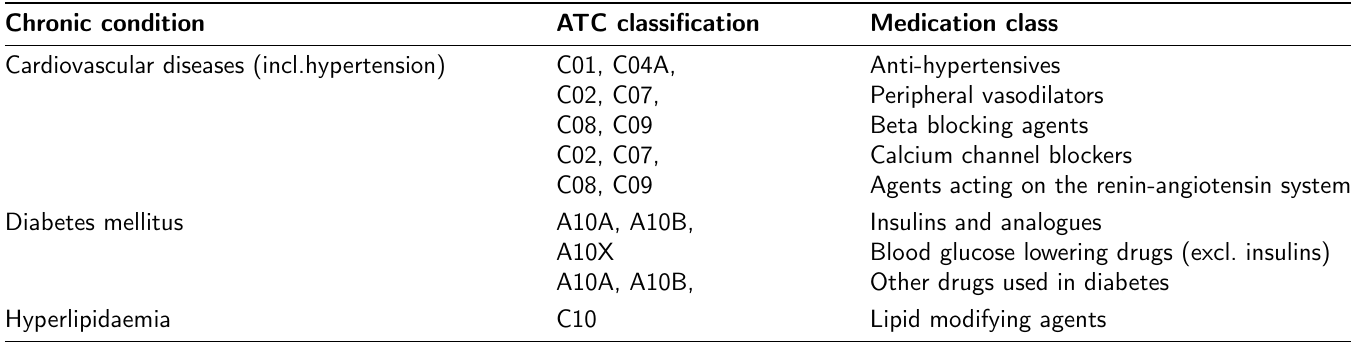
Table 1: ATC classifications of diabetes and associated multi-morbidity groupings